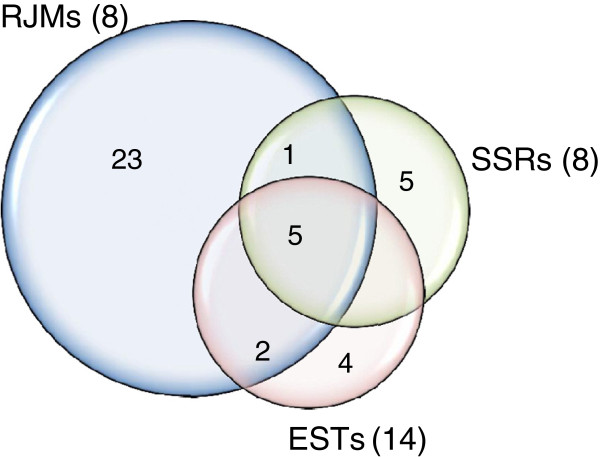
Comparison of RJM, EST and SSR markers in detecting deletions. Venn diagram shows the number of lines with deletions detected with each marker type in a set of 92 lines of the AL8/78-DGRH1 panel. Numbers of markers used from each type are in parenthesis.